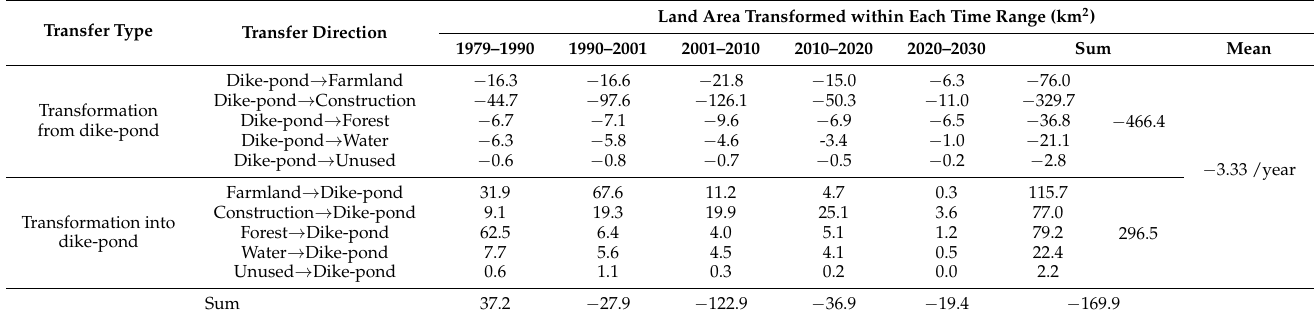
Table 7. Area transfer matrix of dike-pond land in the study area from 1979 to